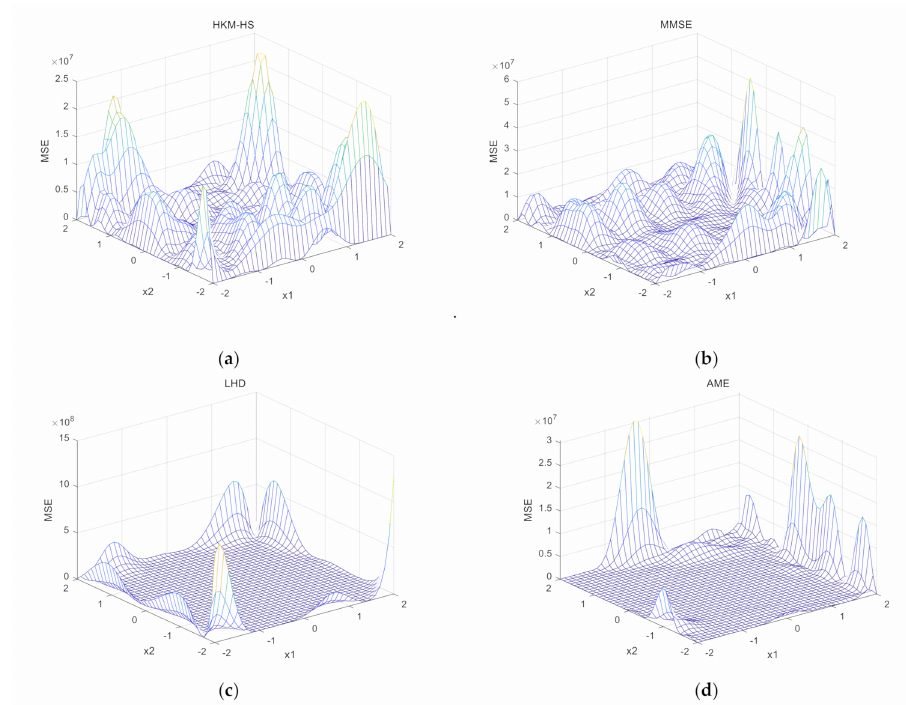
Figure 9. ( a )Test result of Gp function by HKM-HS; ( b ) Test result of Gp function by maximum mean square error (MMSE); ( c ) Test result of Gp function by Latin Hypercube Design (LHD); ( d ) Test result of Gp function by adaptive maximum entropy